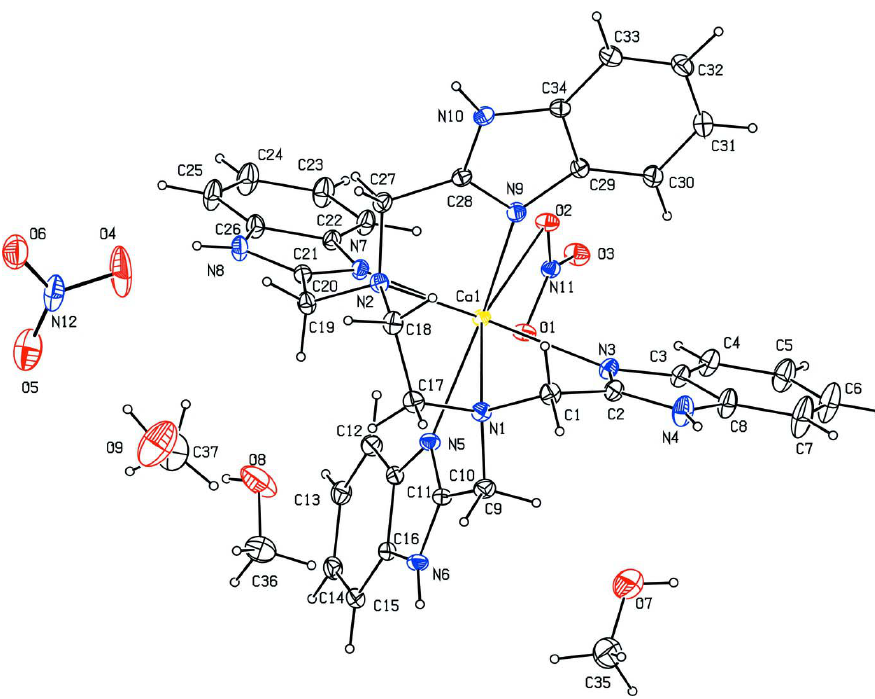
Figure 1 The asymmetric unit of the title compound. Displacement ellipsoids are drawn at the 50% probability level. Only the major component of the disordered nitrate ion is shown.